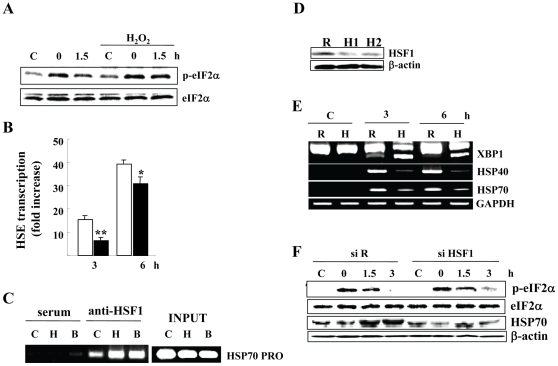
ChIP assay and knockdown of HSF1 transcripts.
A) eIF2α phosphorylation in A172 cells. At the indicated hours after heat exposure (44°c for 20 min) with or without 0.25 mM H2O2 pretreatment, eIF2α activity was evaluated by western blots, and anti-eIF2α protein antibody shows equal loading of protein samples. B) Effect of H2O2 pretreatment on HSE transcription. A172 cells were transiently co-transfected with the pHSE and the pRL-TK reporter genes, pretreated with 0.25 mM H2O2 (closed bars), incubated for the indicated hours after heat exposure (43°c for 20 min), and their transcription activity was evaluated by dual luciferase assays. Bars display the mean ± S.D. of data from three separate experiments and *, P<0.05, **, P<0.01 compared with H2O2-unexposed cells. C) Chromatin immunoprecipitation assays. Cells (C; control) were incubated 2 h after heat exposure (44°c for 20 min) with (B; both) or without (H; heat alone) 0.25 mM H2O2 pretreatment. They were then fixed with formaldehyde, and immunoprecipitated with antibodies against HSF1 (anti-HSF1) or nonimmunized rabbit serum (serum). Immunoprecipitates were amplified by HSF1 promoter primers. A fixed portion of the total input was also examined by PCR (INPUT). D) HSF1 knockdown. Total cell lysates were harvested 36 h after transfection with siRandom (R) or two different siHSF1 (H1 and H2). E) XBP1 splicing. Total RNA was prepared from cells transfected with siRandom (R) or siHSF1 (H; H1). After transfection, cells were exposed to heat (44°c for 20 min) and incubated for the indicated hours. The indicated transcripts were evaluated by RT-PCR. GAPDH mRNA levels ensure that the RNA was correctly quantified. F) eIF2α phosphorylation. After exposure to heat (44.5°c for 20 min), eIF2α phosphorylation and HSP70 expression were evaluated by western blots. Anti-eIF2α protein antibody (in A and F) and anti-β-actin antibody (in D and F) show equal loading of protein samples.